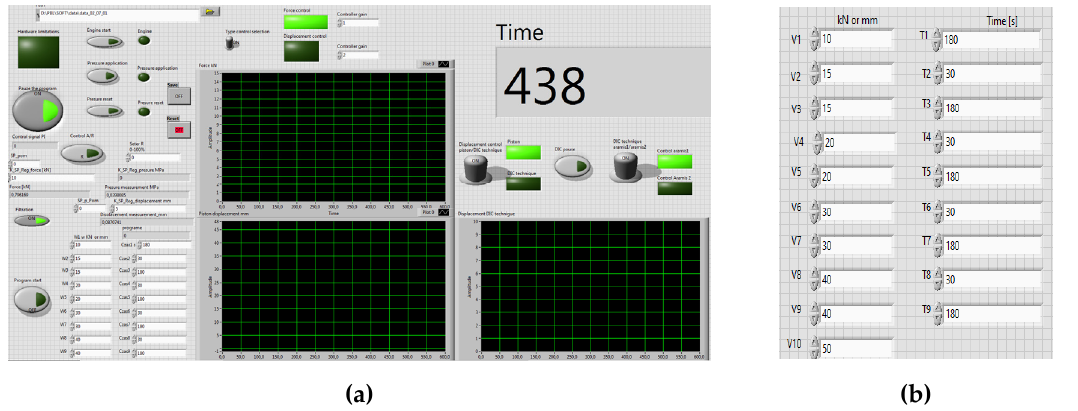
Figure 15. Testing programme: ( a ) general view of the user interface, ( b ) data on loading / displacement over the function of time.